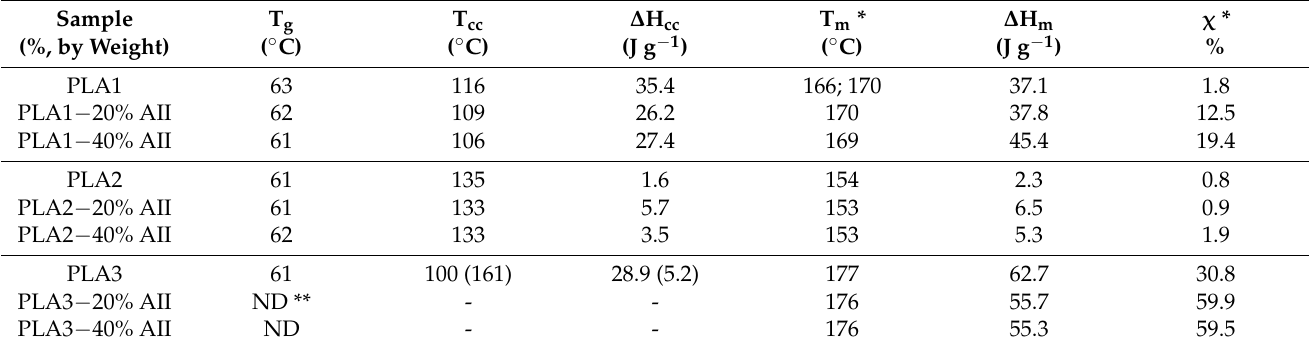
Table 3. Comparative DSC results of neat PLAs and PLA–AII composites obtained using different PLA grades as polymer matrix (second DSC heating scan, by 10 ◦ C/min).